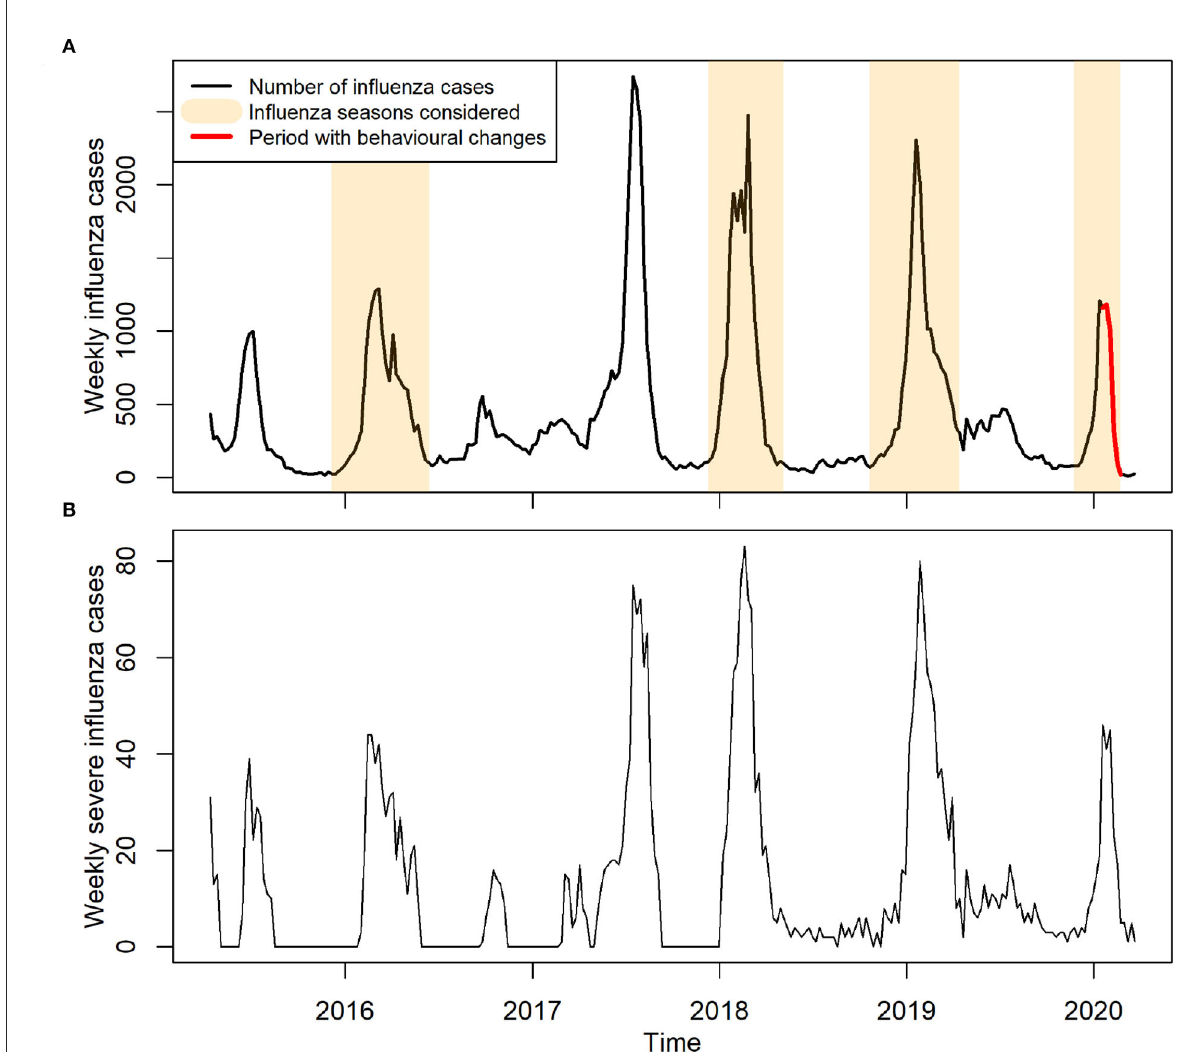
FIGURE1 Reported cases of influenza in Hong Kong between years 2015 and early 2020. (A) Weekly reported influenza cases. Influenza seasons considered for model training are highlighted in light brown color, indicating an ordinary influenza period. Red color indicates the period